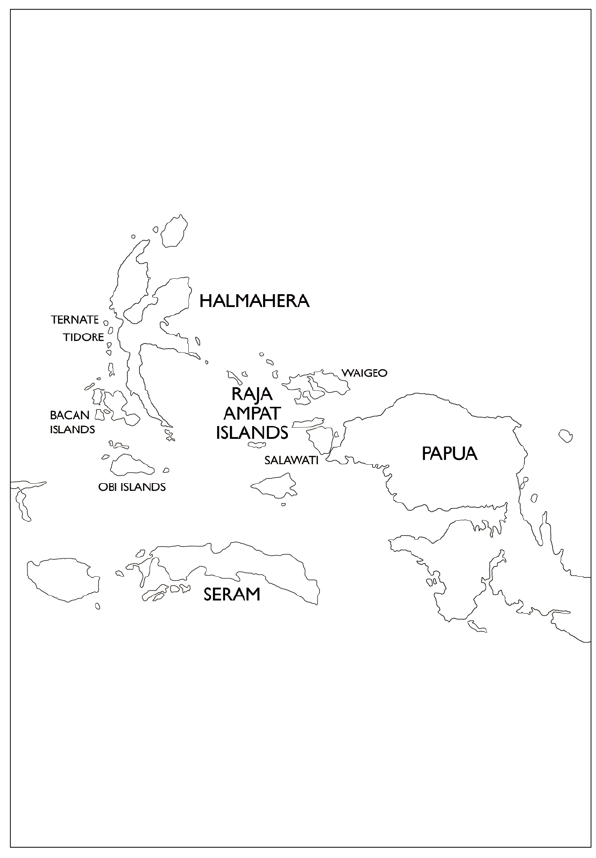
Figure 1. Map of North Maluku and Raja Ampat.